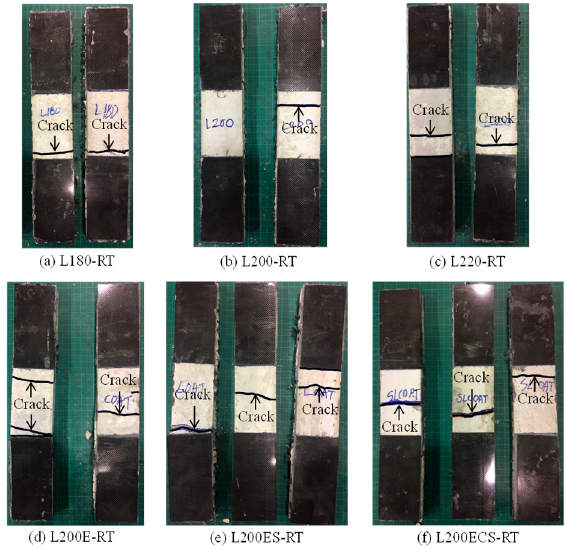
Figure 9. Failure modes of TRM test specimens in the first and second series.